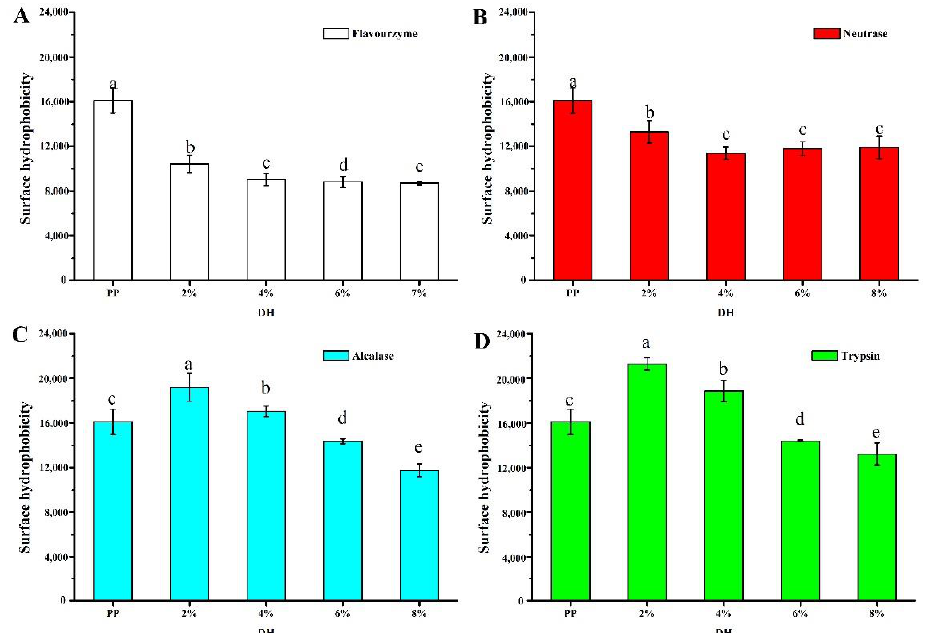
Figure 3. Surface hydrophobicity of PP and PP with different DH. The values reported represent means ( n = 3) ± SDs and different superscript letters indicate significant difference ( p < 0.05). (( A – D ) are flavourzyme, neutrase, alcalase and trypsin treatment, respectively).